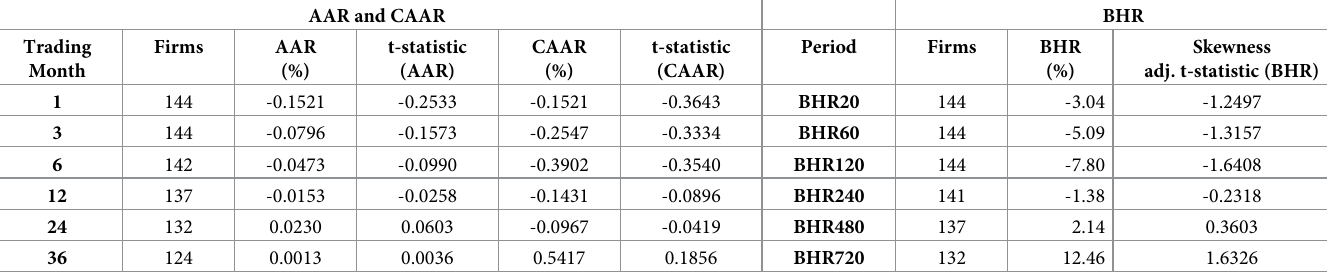
Table 2. Average monthly market-adjusted returns (AARs) and BHRs.